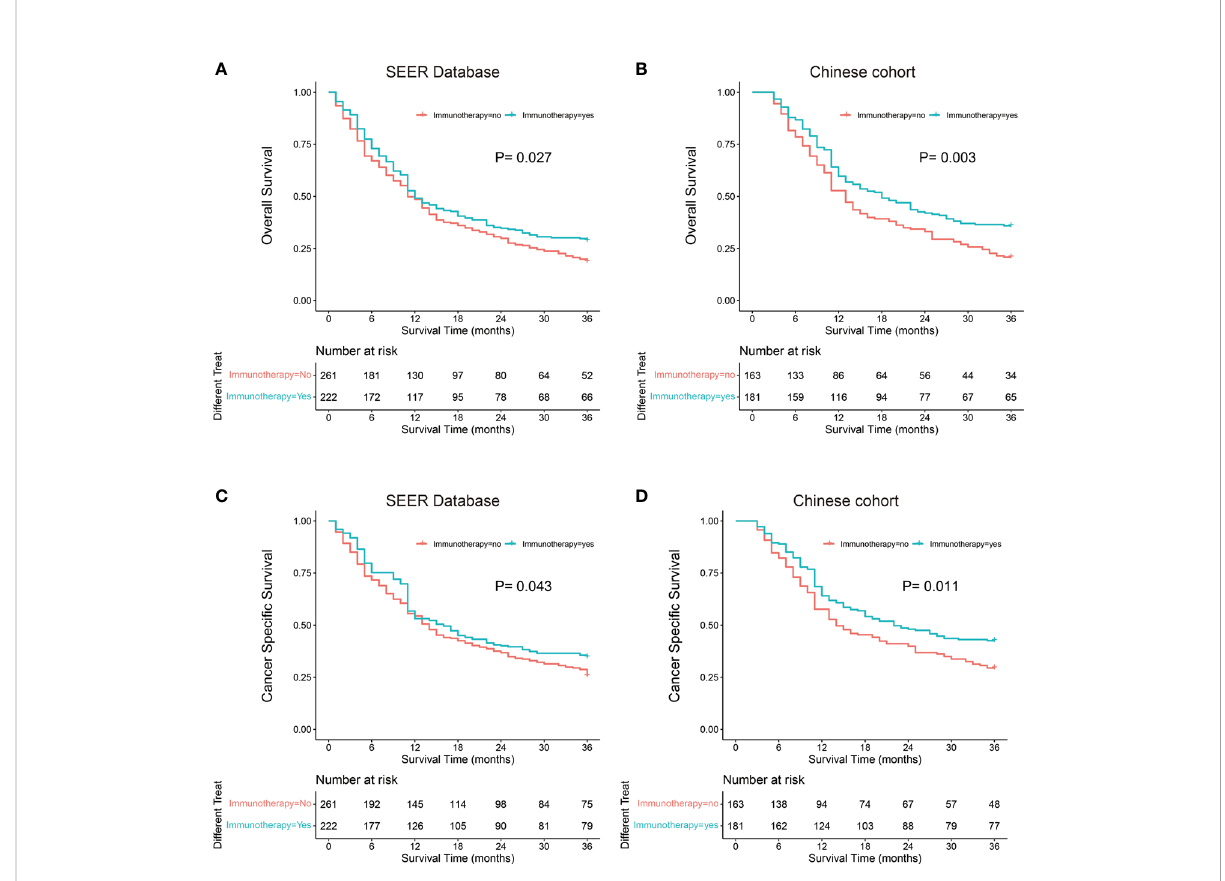
FIGURE 2 Kaplan-Meier probability plots of Overall Survival and Cancer Speci fi c Survival between the Immunotherapy group and the No immunotherapy group: SEER Database (A, C) and Single-Center cohort (B, D)